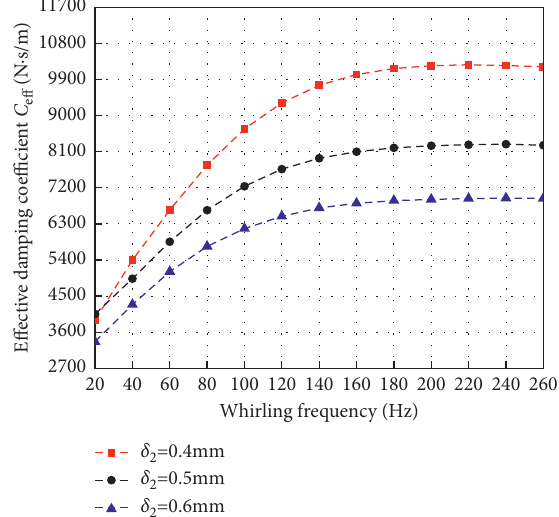
Figure 27: Effective damping coefficient vs. whirling frequency.